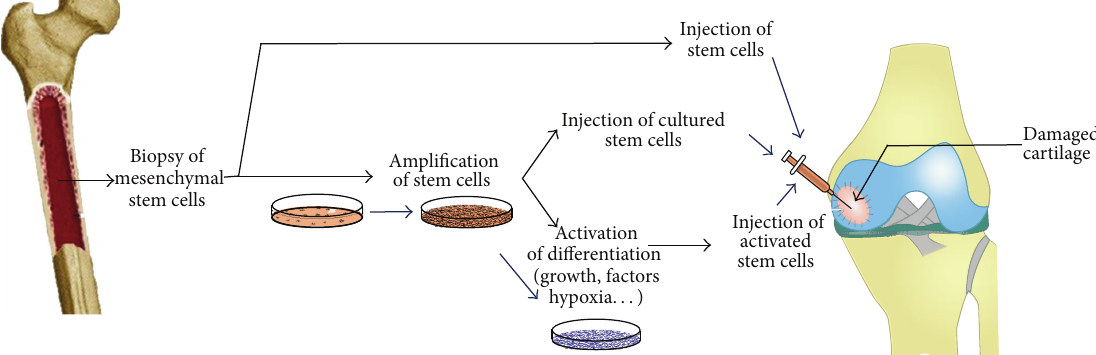
Figure 3: Schematic representation of cell therapy for cartilage based on stem cell implantation. Mesenchymal stem cells (MSCs) are isolated from different sources: bone marrow, fat tissues, or umbilical cord. Synovial-derived cells or MSCs derived from skeletal muscle can also be used. Then, these cells are either injected into damaged zone of cartilage or amplified in vitro . After amplification, stem cells are injected into damaged cartilage directly or after a stage of activation toward chondrogenesis by addition of growth factors, cultured in hypoxia and in an adapted